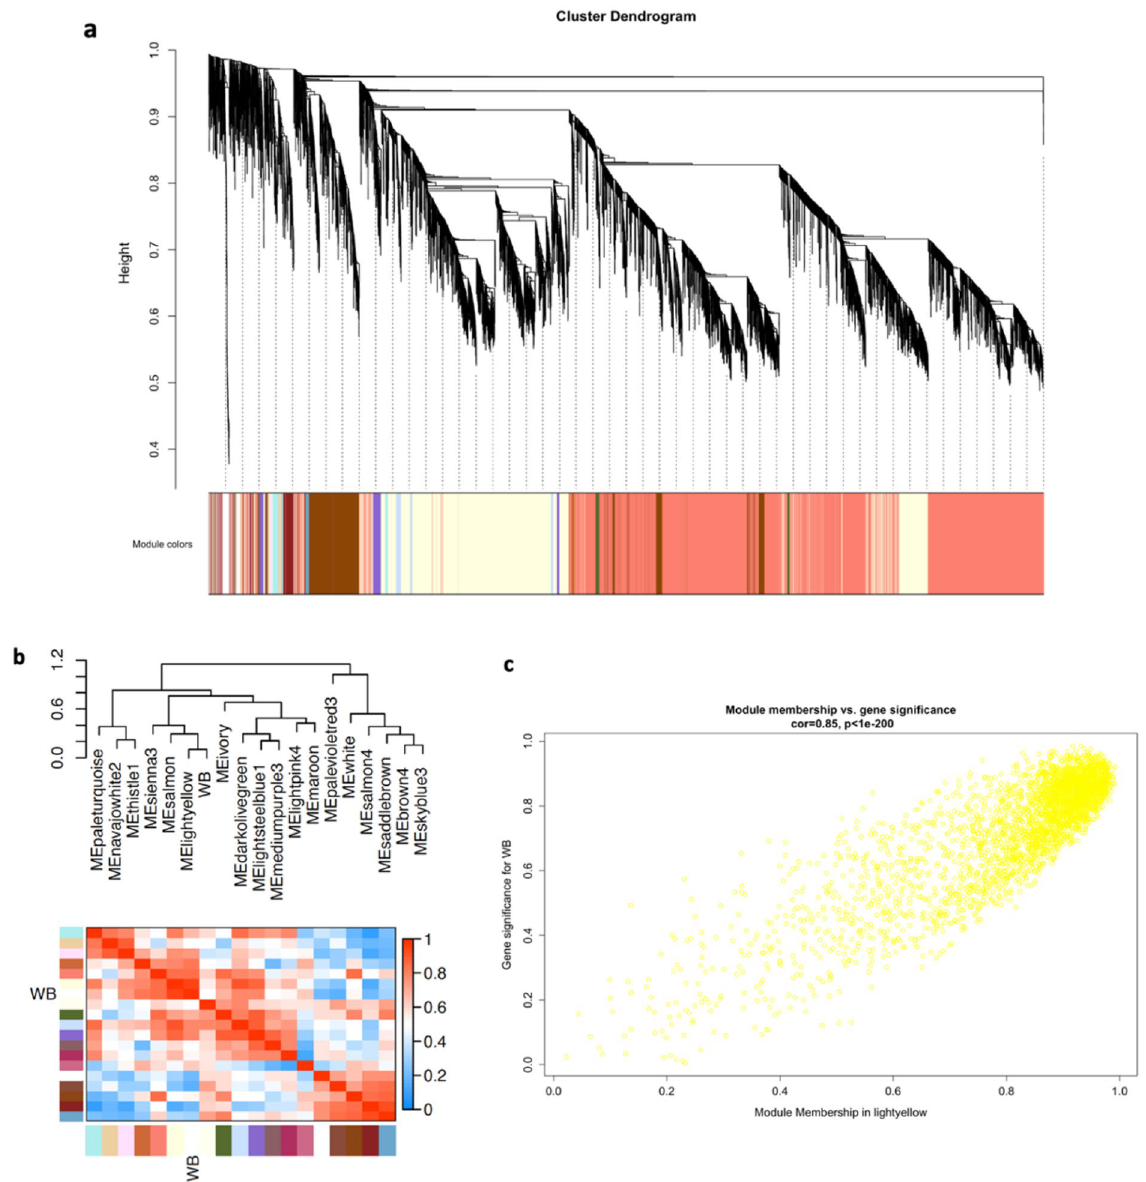
Figure 2. Weighted gene co-expression network analysis of combined RNA-seq and metabolomics data. a. Hierarchical cluster tree of co-expression modules; b. Eigengene network showing relationships among modules and wooden breast myopathy (WB); c. Scatterplots of gene significance (GS) for WB versus module membership (MM) in the lightyellow module. This figure was generated in R v3.5.2 (https:// www.R- proje ct. org/) using package WGCNA v1.70-3 (http:// horva th. genet ics. ucla. edu/ html/ Coexp ressi onNet work/ Rpack ages/